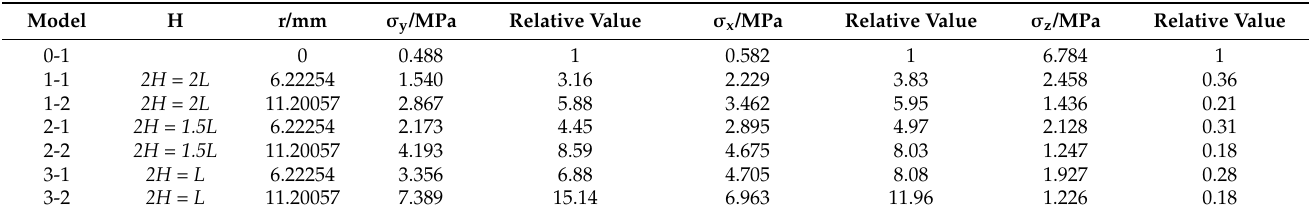
Table 1. Summary of numerical modeling results.